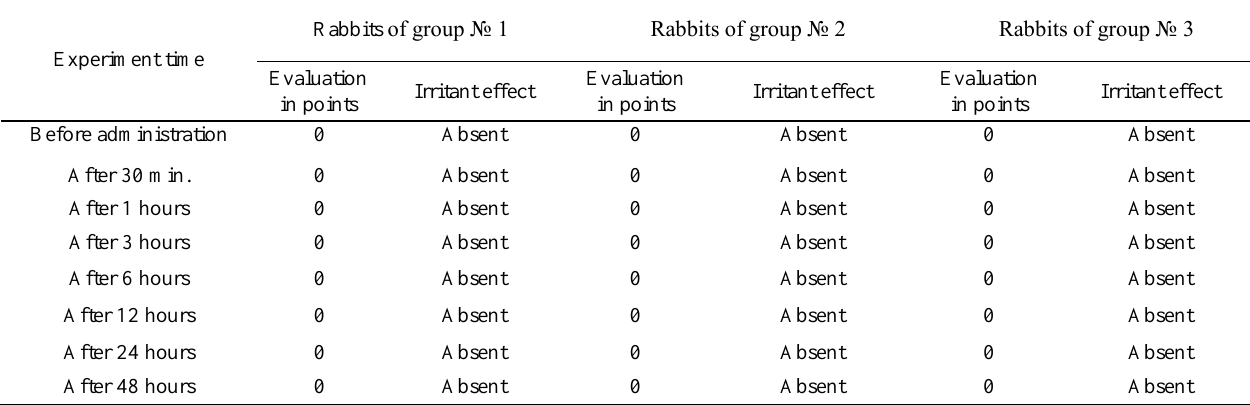
The thickness of the skin folds of rabbits after application of the ferrocellus T (M ± m; n = 3) Group of animals № Ferosel-T (dose) Control (C) – 6 ml/kg b.w. (isotonic sodium chloride solution) Prophylactic (D 1 ) 1 ml/kg b.w. Therapeutic optimal (D 2 ) 2 ml/kg b.w. Therapeutic maximal (D 3 ) 6 ml/kg b.w. Probable toxic (D 4 ) 10 ml/kg b.w. Influence of Ferosel T on Conjunctivitis, Cornea and Eyelid of the Rabbit's Eye (M ± m; n = 3)